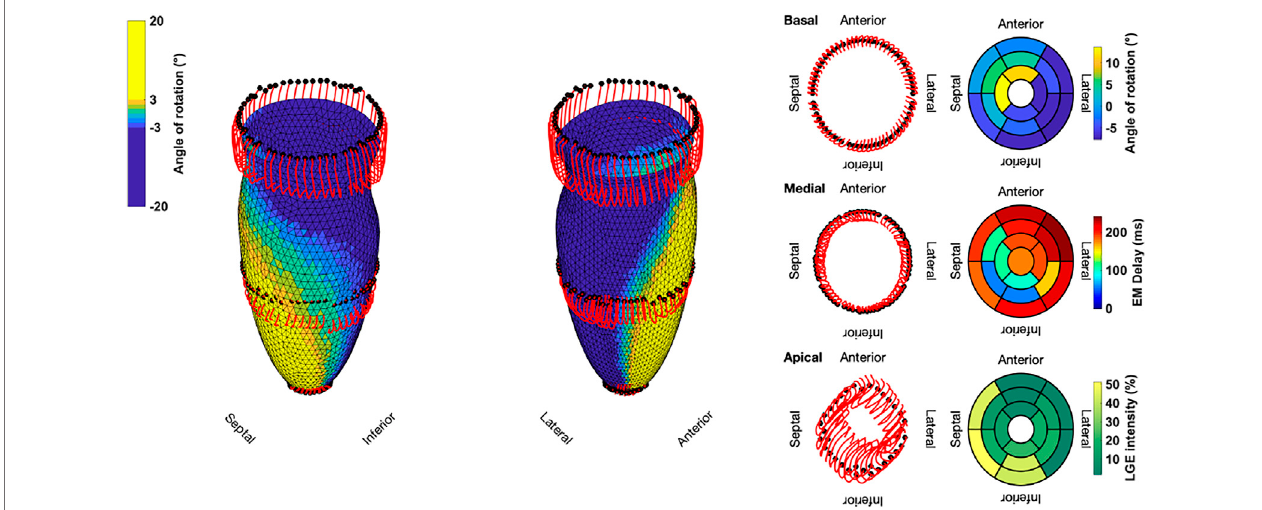
FIGURE 5 | Three-dimensional trajectories (red lines) of selected points on the endocardium in the basal, medial, and apical sectors for Case 18. The endocardial surface during end-systole is shown with rotational values depicted on the faces of the mesh. Solid black dots represent the initial positions. Bullseye plots show the segmential mean values of the angle of rotation, electromechanical (EM) delay, and LGE intensity.